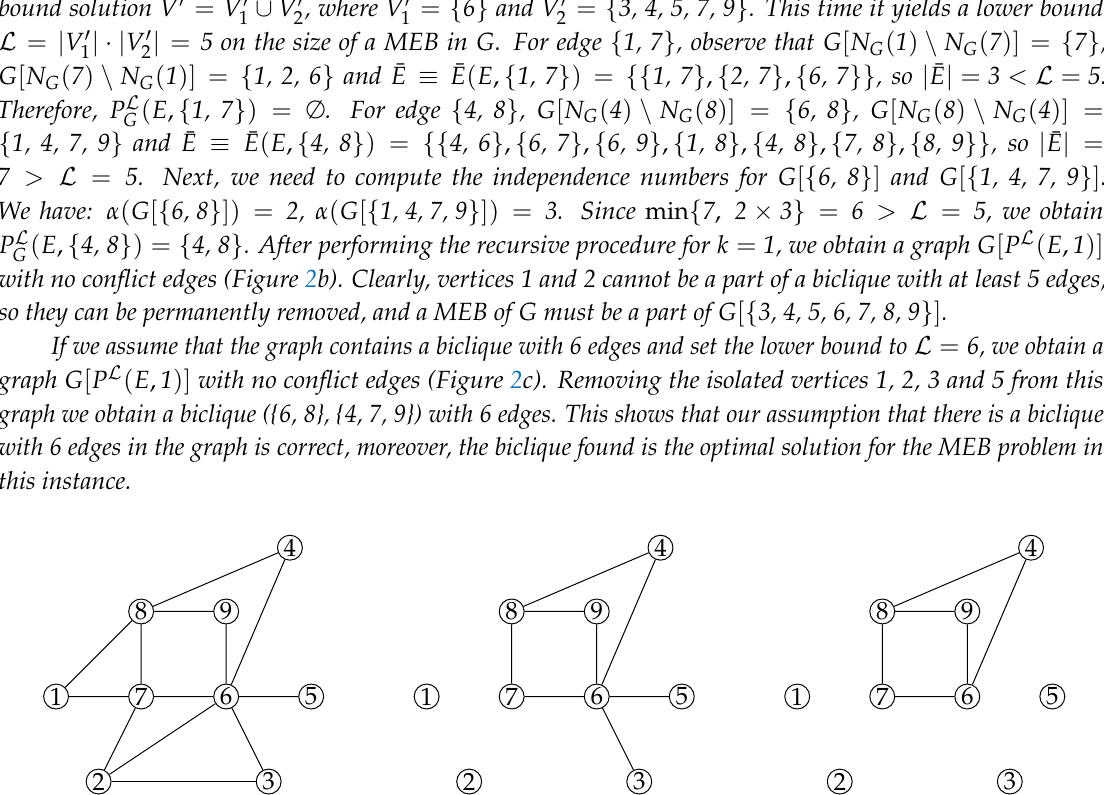
Figure 2. Graph G = ( V , E ) and the induced subgraph G [ P L ( E ,1 )] for